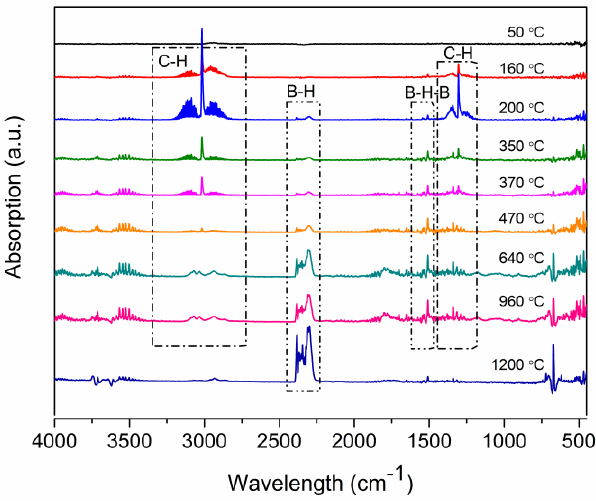
Figure 4. The FTIR spectra of gas products released at different temperatures of pyrolysis.